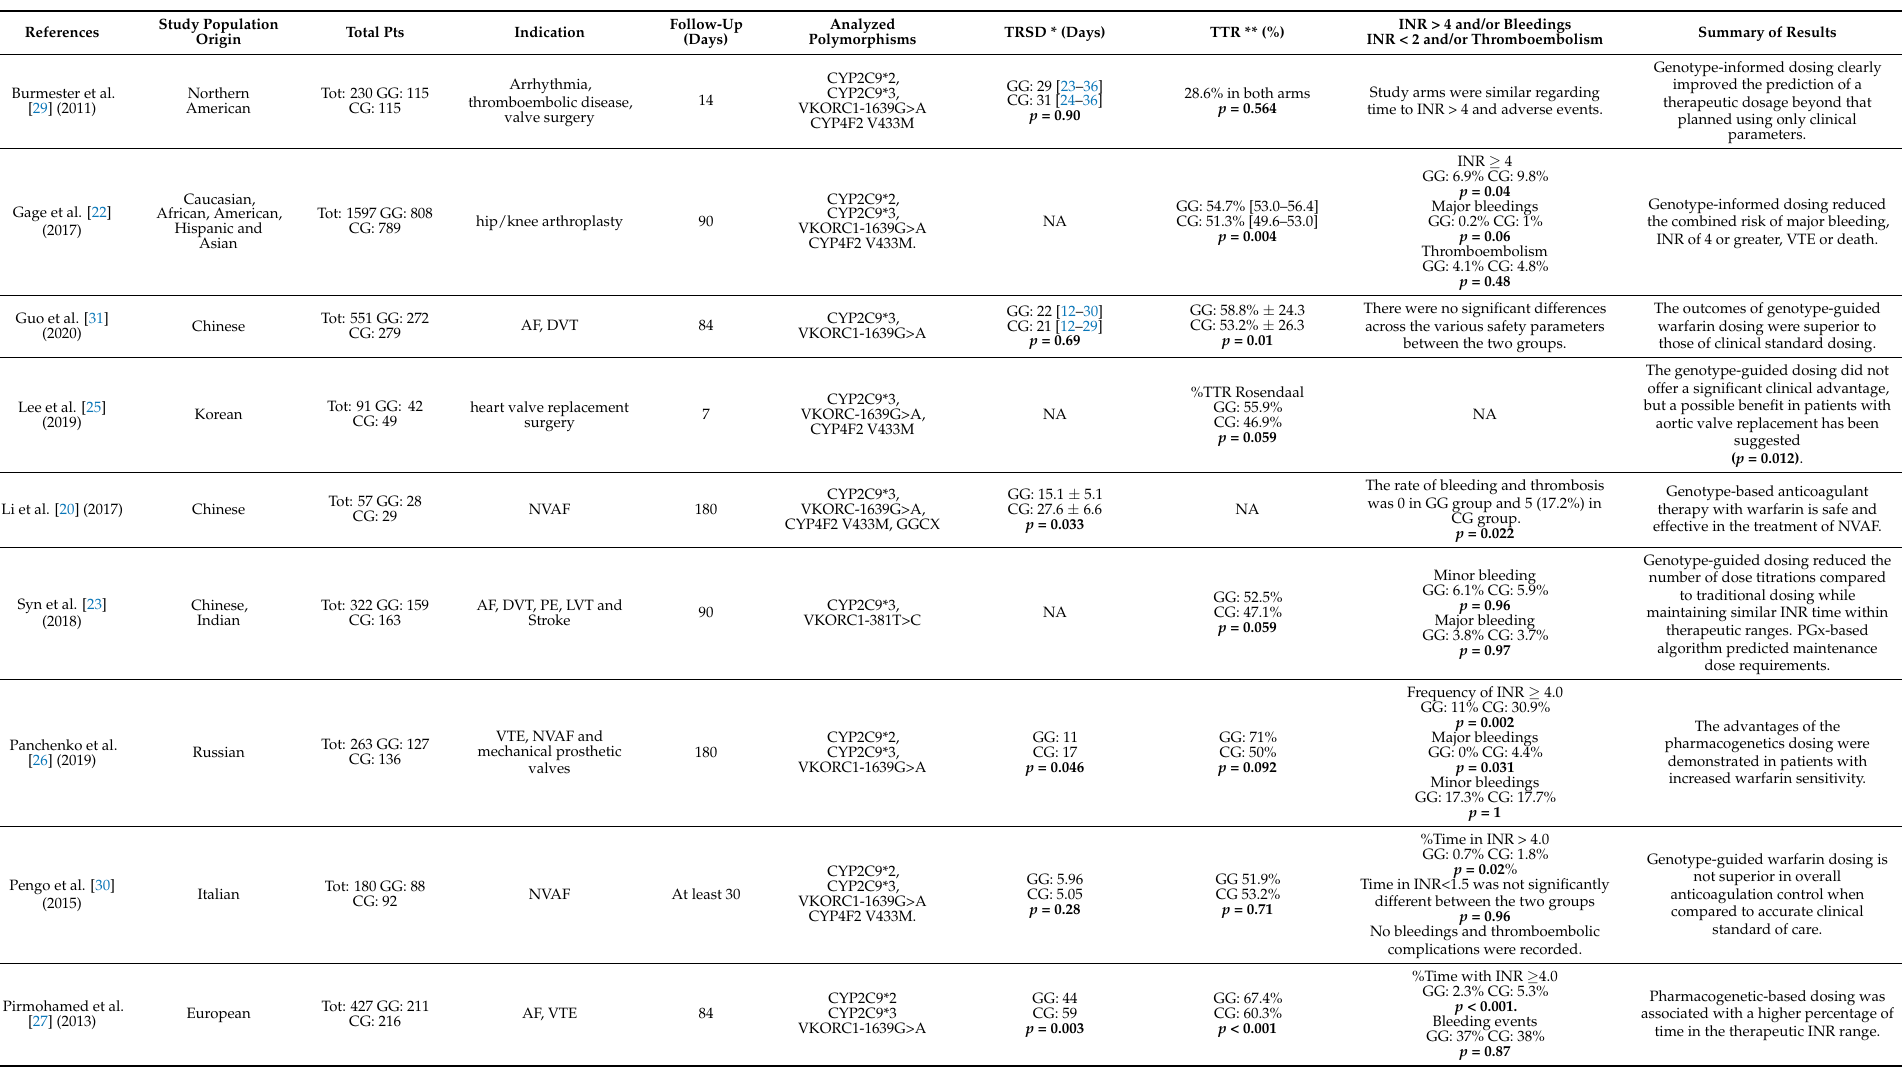
Table 1. Characteristics of the RCTs reporting data on VKA sensitivity and/or resistance.